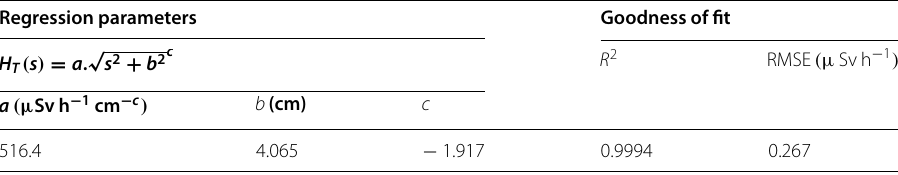
Two goodness‑of‑fit criteria are additionally provided for each regression: the coefficients of determination ( R 2 ) and the root mean square error (RMSE)